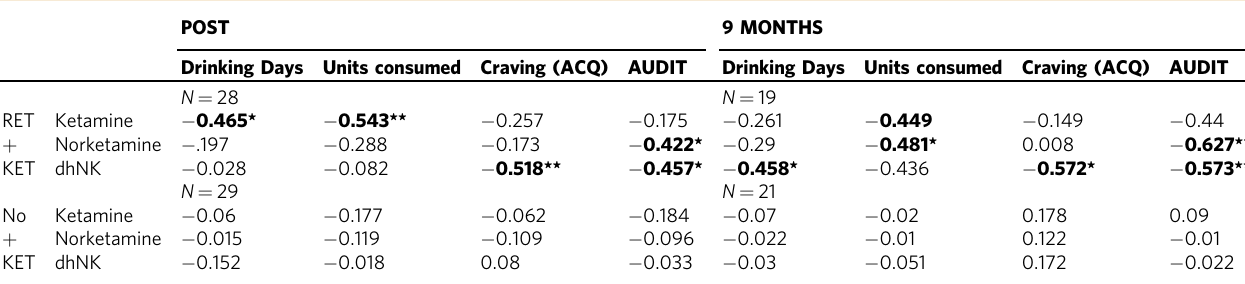
Table 2 Spearman ’ s rank correlations between ketamine metabolism and primary drinking outcomes post manipulation (Day 10) and at fi nal follow-up (9 months)